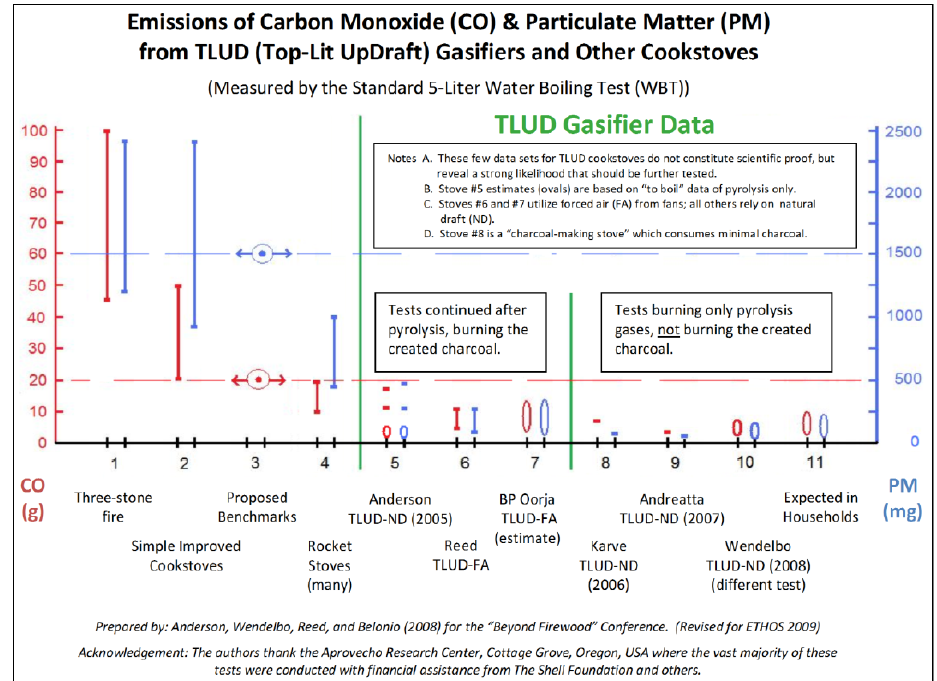
Figure 2. Comparison of CO and PM emissions from various combustion technologies and systems [16].